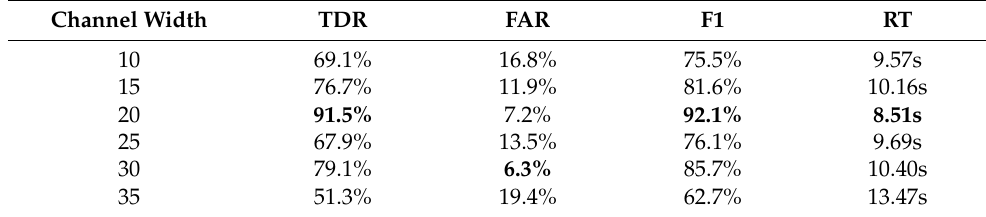
Table 4. The anomaly detection results under different channel widths (the scanning period is 4096).